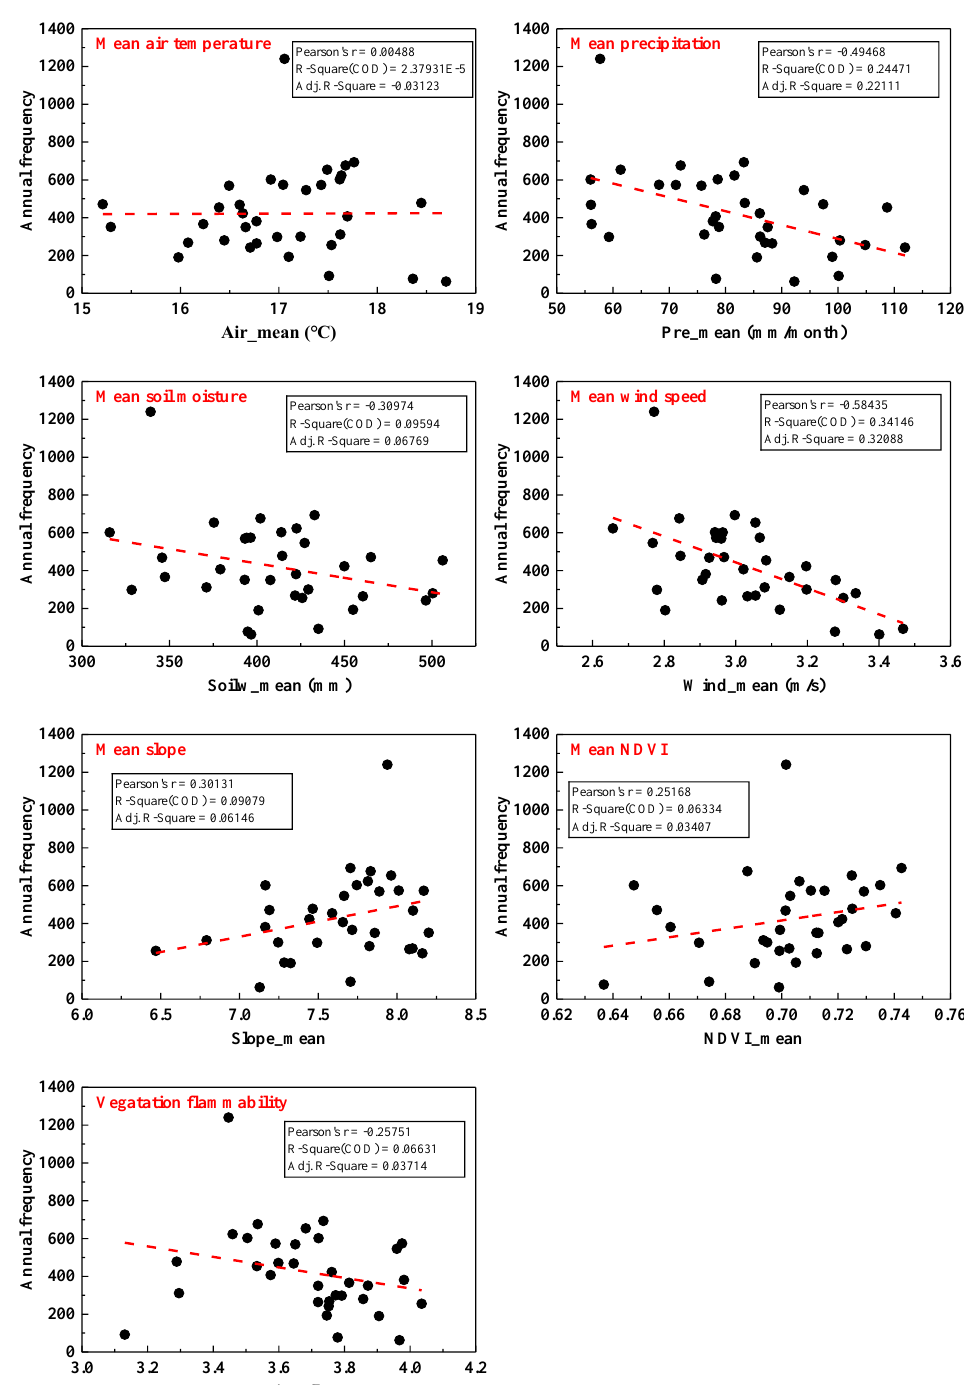
Figure 6. Scatter plot of the annual frequency of bushfires as a function of seven categories of influencing factors’ variations (temperature, precipitation, soil moisture, wind speed, terrain slope, NDVI and vegetation flammability).